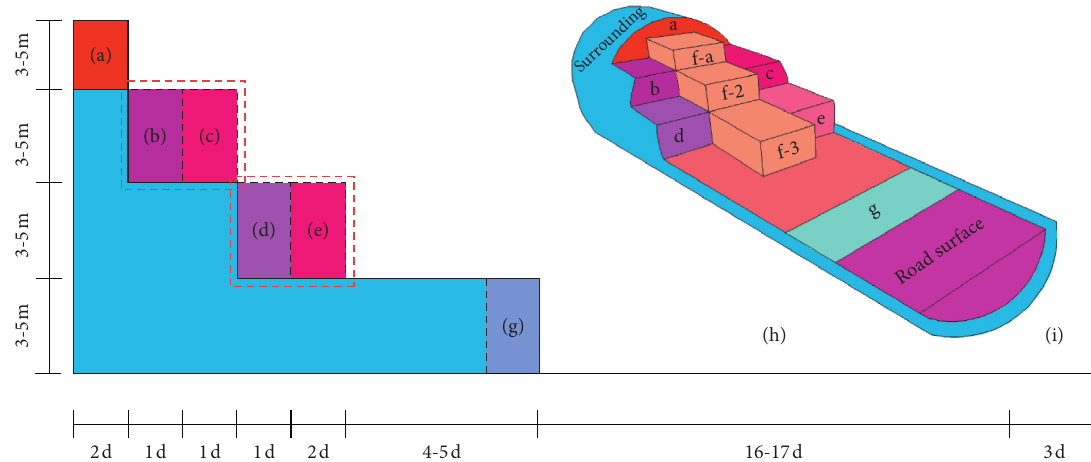
Figure 2: Three-step and seven-step excavation. (a) Excavation of upper stage, (b) left of middle step, (c) right of middle step, (d) left of lower step, (e) right of lower step, (f) excavation of core soil, (g) excavation of inverted arch, (h) clamping secondary lining formwork, and (i) removal of secondary lining